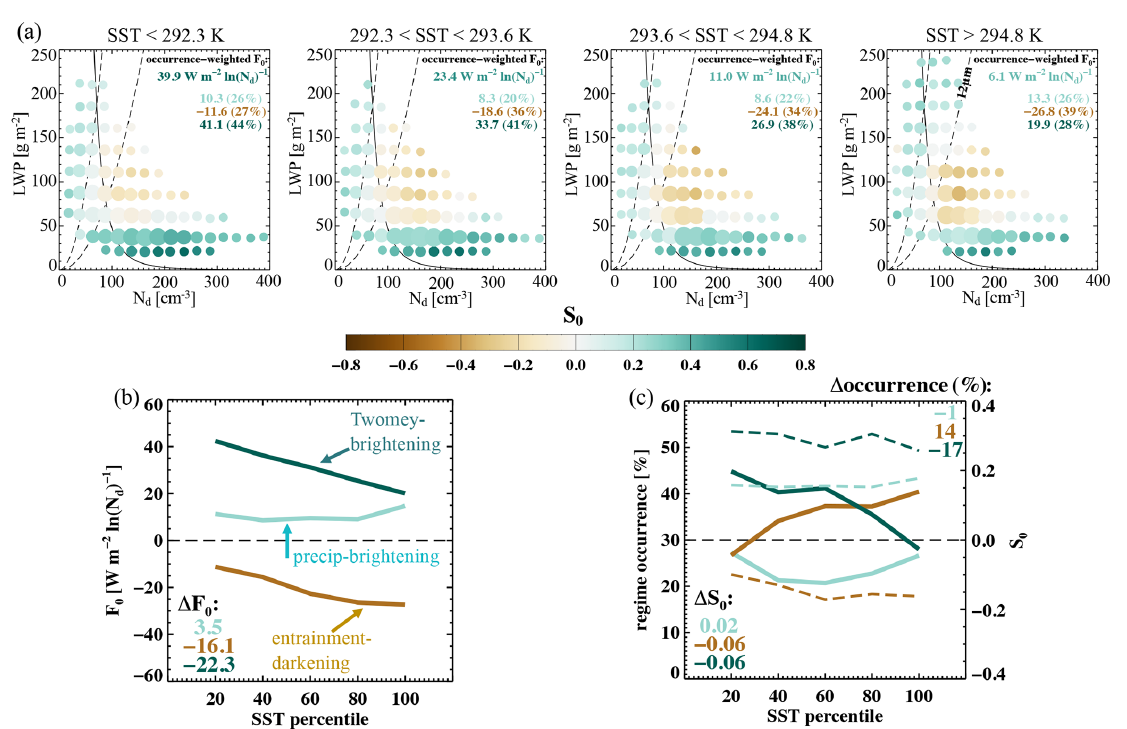
Figure 9. As in Fig. 6 but for sea surface temperature (SST).